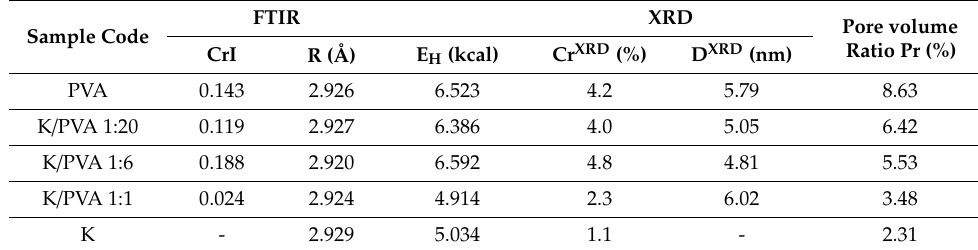
Table 2. The characteristics of the obtained